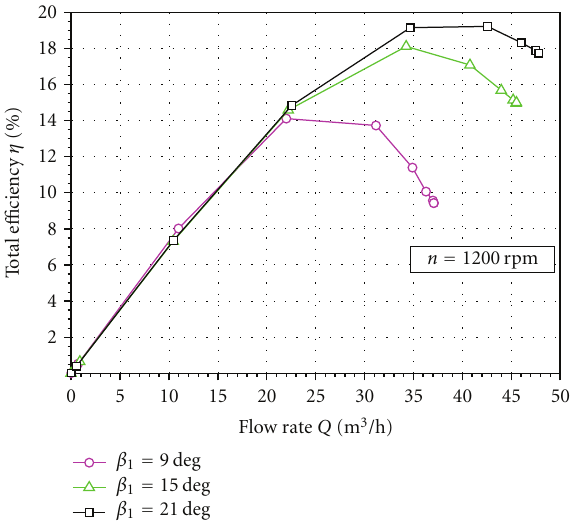
Figure 6: Representation of the mean blade line using DASM.